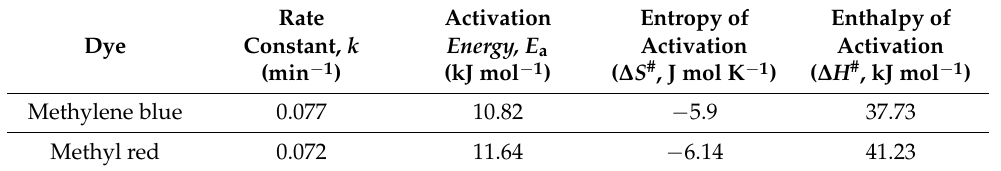
Table 2. Kinetics and thermodynamics parameters of solar/CS-NM photocatalysis of MB and MR.